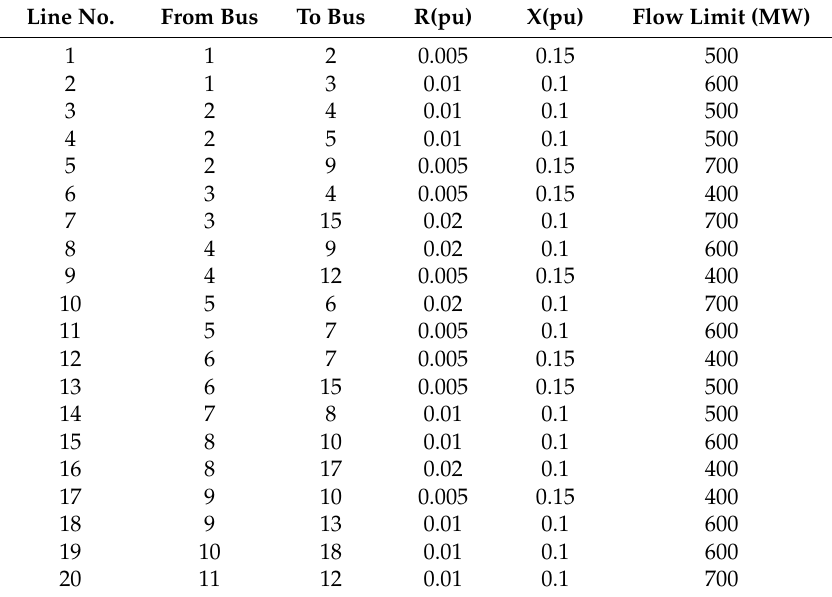
Table A3. Transmission line